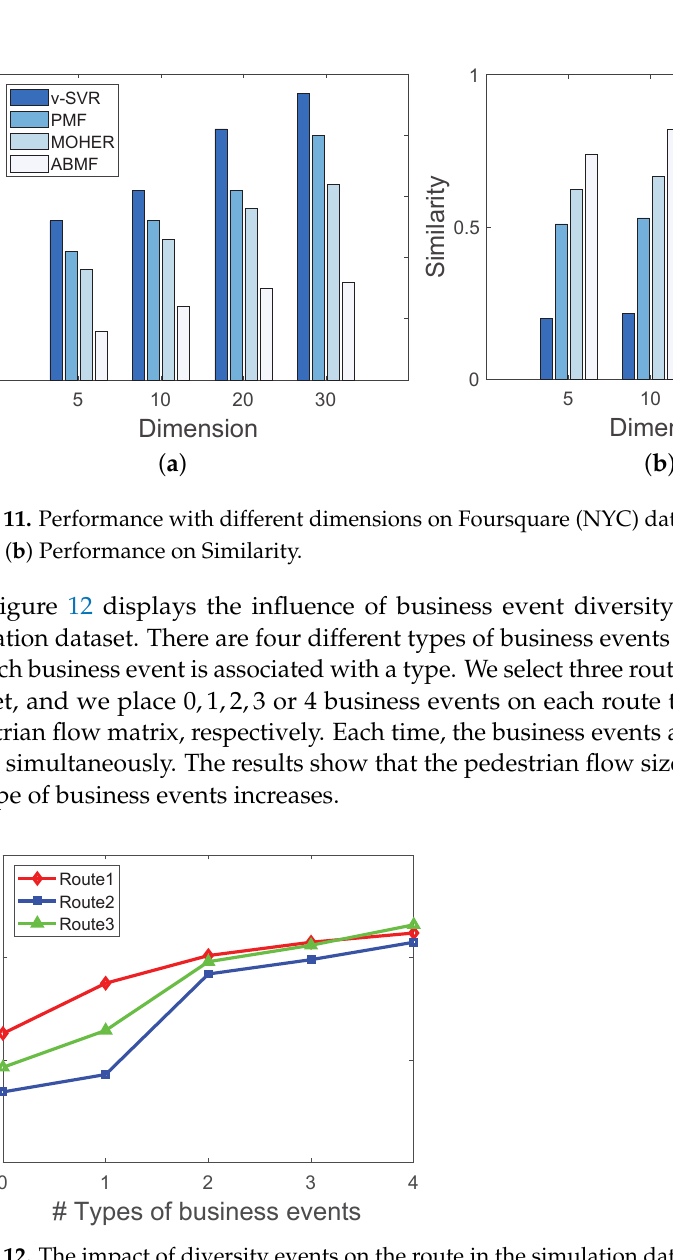
Figure 12. The impact of diversity events on the route in the simulation